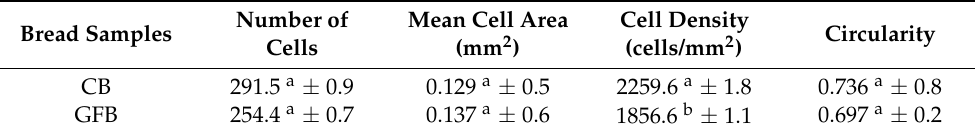
Table 5. Main morphological properties of crumb structures of Gluten Friendly™ bread (GFB) and control bread (CB) 1 .